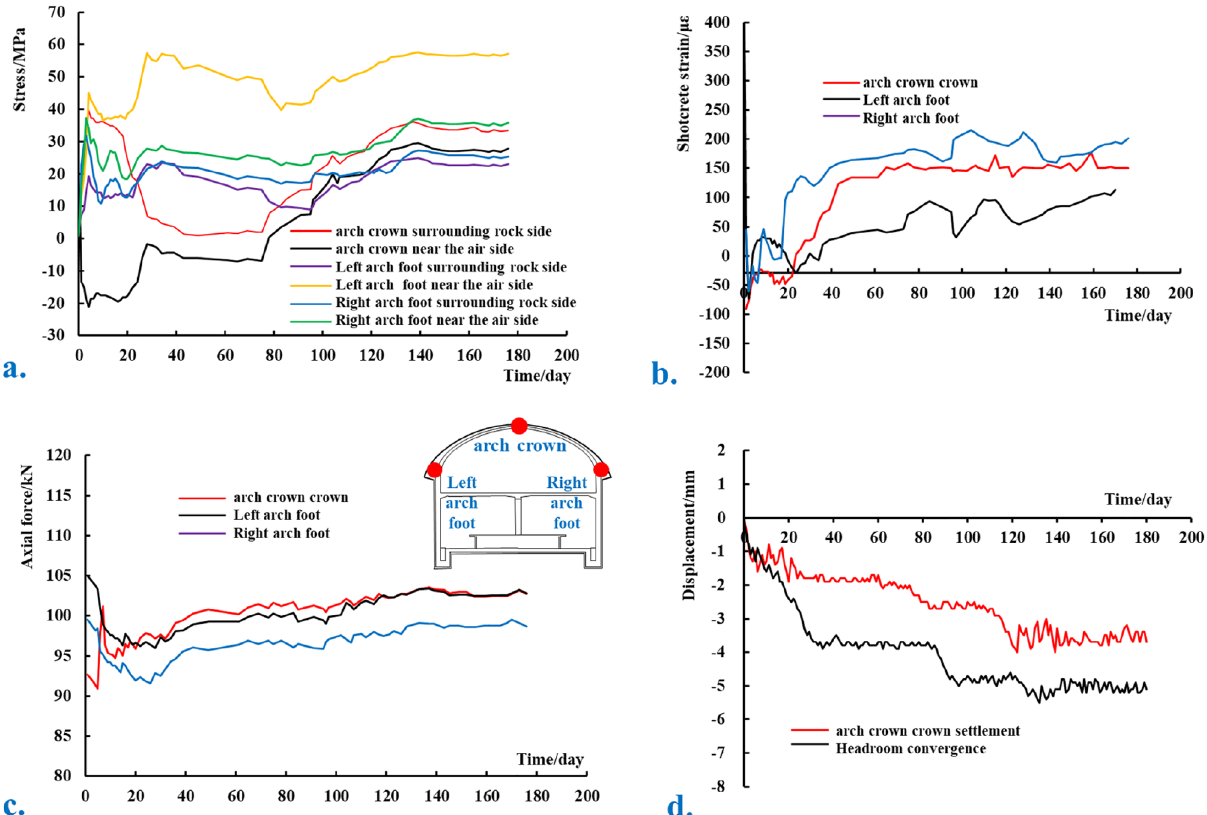
Figure 22. Field monitoring data diagram of a certain section of the primary section. ( a ) Stress of supporting arches; ( b ) strain of shotcrete; ( c ) axial force of rock bolts; ( d ) displacement of surrounding tunnel excavation width and L represents the horizontal distance from the excavation surface to the moni- toring point. When the monitoring value is relatively stable, the monitoring frequency can be appropriately reduced, and when abnormal conditions or poor geological conditions occur, the monitoring measurement frequency can be increased. Monitoring data. During field monitoring, the reinforced axial force instrument is used to measure the stress of the steel bar of the supporting arches, where a positive value is compressive, and a negative value is tensile. The shotcrete strain instrument is used to measure the shotcrete strain after the initial spraying, where a positive strain is compressive, and a negative strain is tensile. The axial force of the prestressed rock bolt is measured by the rock bolt axial force instrument, where a positive axial force is tensile, and a negative force indicates pres- sure. A total station is then used to measure arch crown settlement, where a negative value indicates settlement, and headroom convergence, where a negative value indicates convergence toward the empty surface. Through a period of field monitoring, a large amount of data has been obtained, and the data of a certain section of the primary section are shown in Fig. 22. Comprehensive analysis is performed by combining field monitoring results and numerical simulation results. The stress of the supporting arch reinforcement is primarily compressive, and the maximum compressive stress appears in the left arch foot area, which is approximately 57.5 MPa, far lower than the yield strength of 400 MPa, and tends to be stable in approximately 30 days. The axial force of prestressed rock bolts is primarily under ten- sion, and the maximum value is approximately 103 kN. After monitoring the initial prestress loss, there is a small decrease that stabilizes after approximately 10 days. The axial force of the rock bolts is greater than the numerical calculation result, and the active support effect is significant. The strain of the shotcrete is primarily compressive strain, and the maximum strain occurs in the left arch foot area, which is approximately 215 με. The strain change is small, and the maximum strain is less than the ultimate compressive strain. The axial force of the supporting arch reinforcement, the axial force of the rock bolts, and the strain of the shotcrete are all less than its yield limit. With the increase of time, the settlement of arch crown increases rapidly at first, then slowly, and finally tends to be stable. The maximum settlement of the arch crown is approximately 4 mm, which is similar to the numerical simulation results. This shows that the new technology is more consistent with the actual situation on site and reduces the occurrence of engineering accidents. Based on observations in the field (see Fig. 23), no major deformation occurred in the arch crown and other positions. The monitored value is within a safe range, and there is a certain safety reserve.